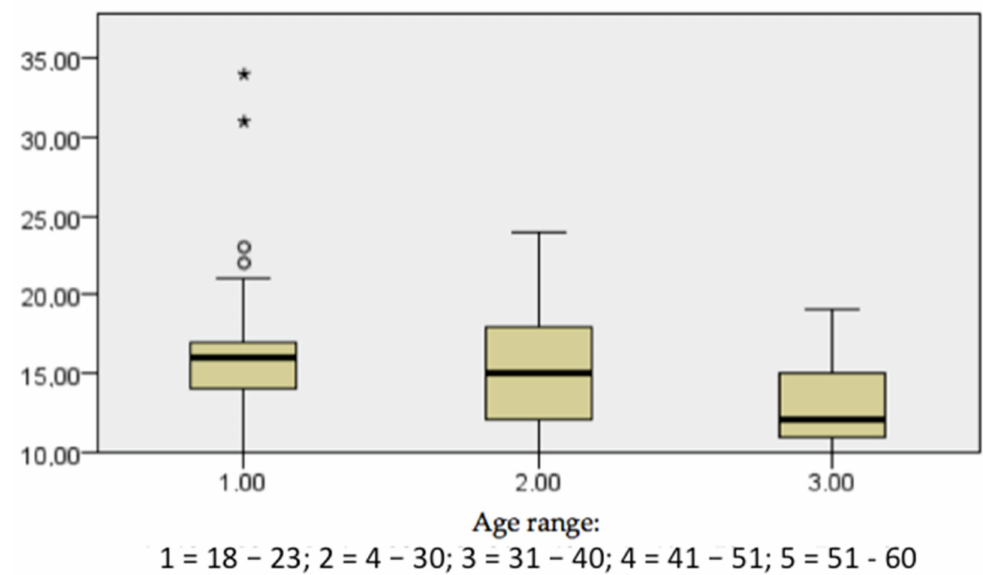
Figure A5. Average ranges of the Psychological Distress in Non-Formal Contexts scale as a function of the years of experience variable. * Values more than 3 interquartile ranges, ◦ Values more than 1.5 but less than 3 interquartile ranges.